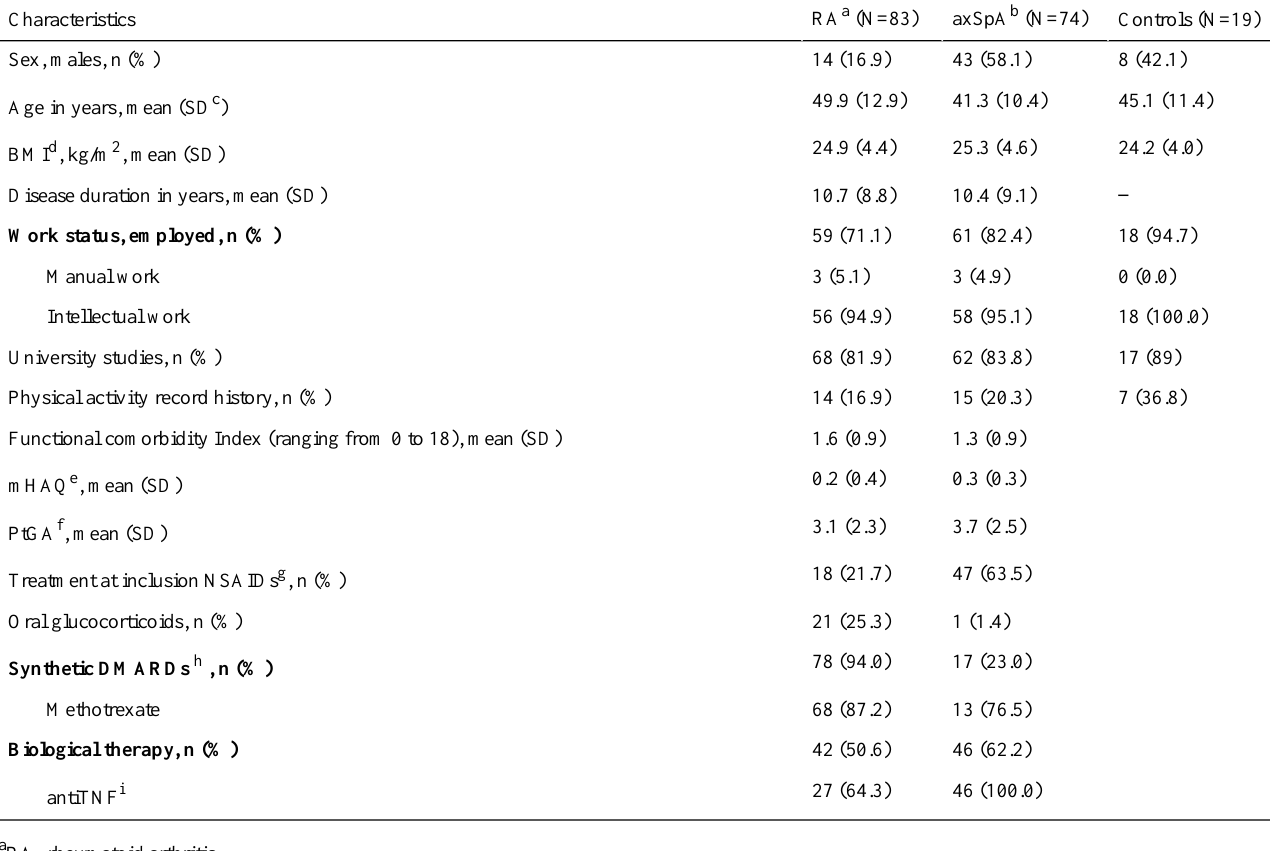
Table 1. Characteristics of 157 patients and 19 controls participating in an observational study of physical activity using an activity